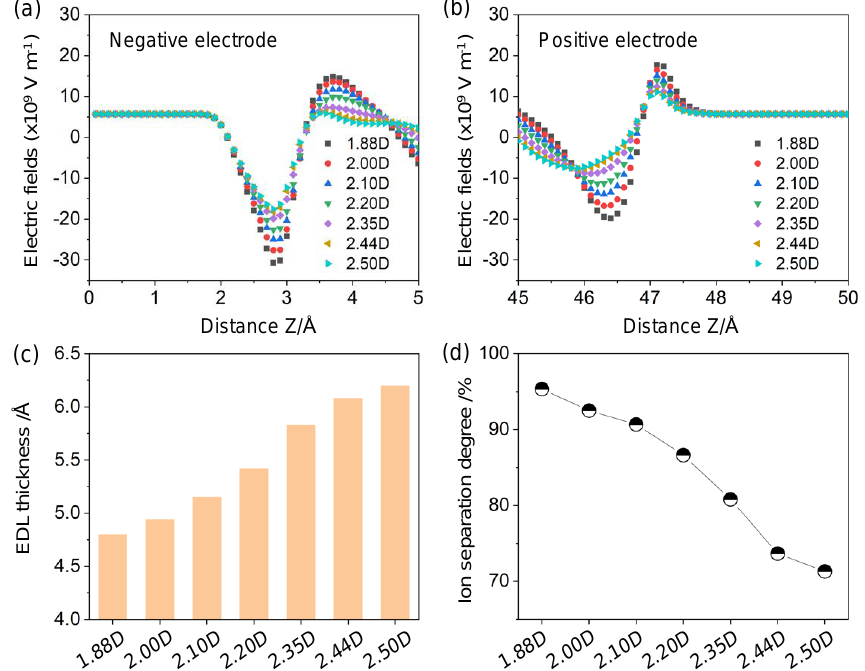
Figure 3. Electric field distributions near the ( a ) negative and ( b ) positive graphene electrodes; ( c ) EDL thickness and ( d ) ionic separation degree at different solvent polarities.